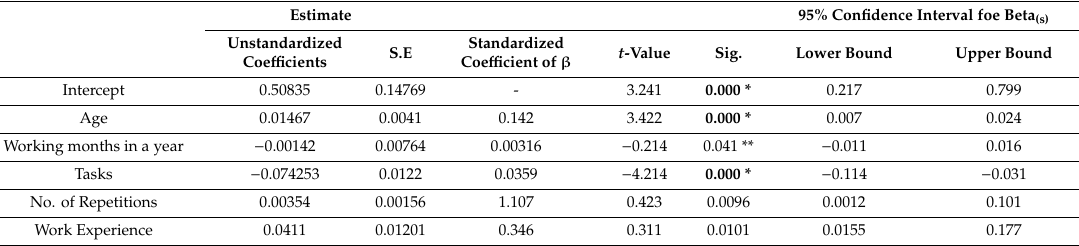
Table 5. Parameter Estimates (Coe ffi